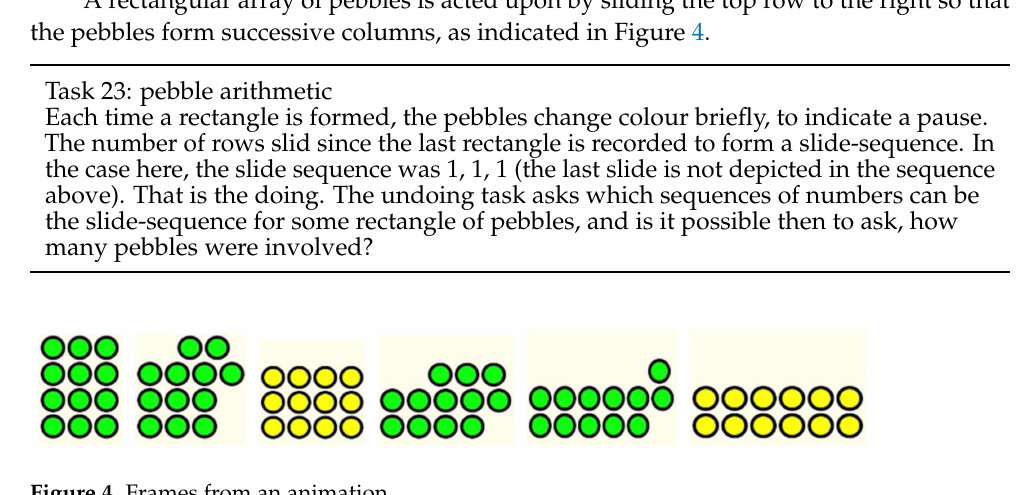
Figure 4. Frames from an